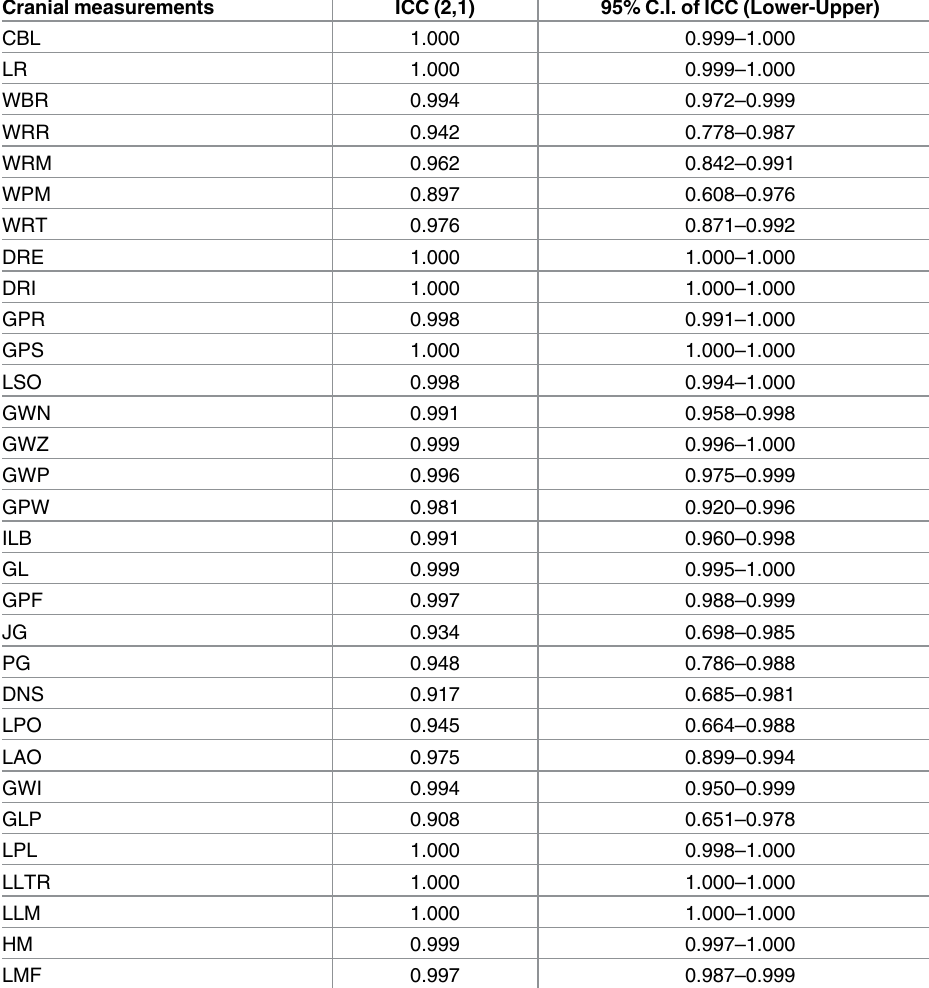
Table 4. Inter-operator (reproducibility) variability of cetaceancranial measurements obtained by CT